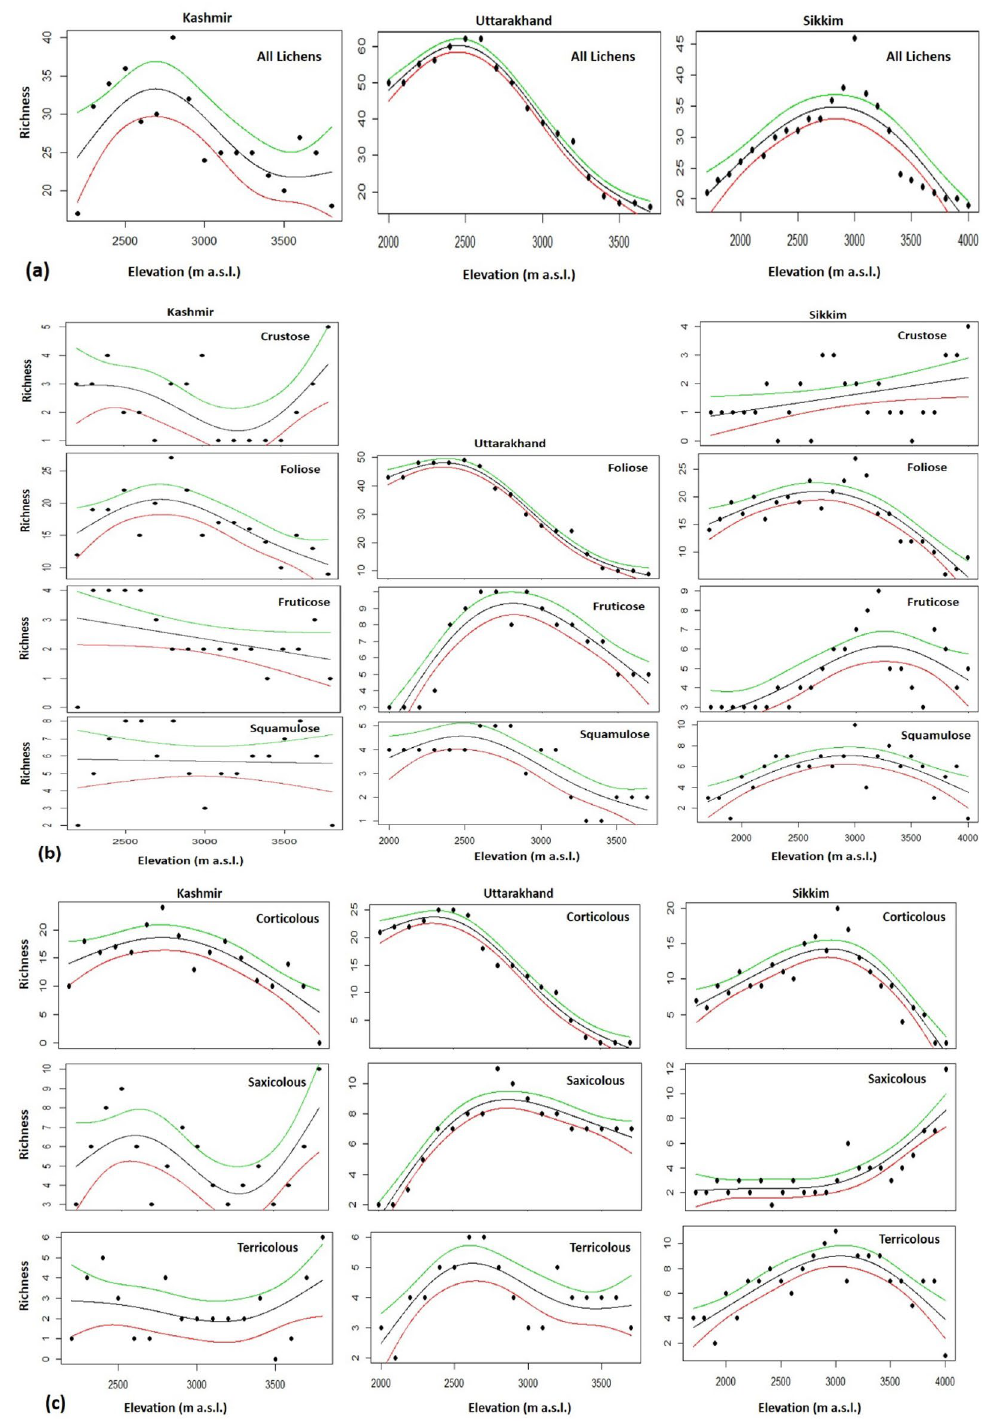
Figure 8. Relationship between species richness and elevation. (a) Total lichen richness, (b) functional groups and (c) habitat groups across three different regions of Kashmir, Uttarakhand and Sikkim. The middle black line represents the actual richness, upper (green line) and lower (red line) represent the 95 per cent confidence